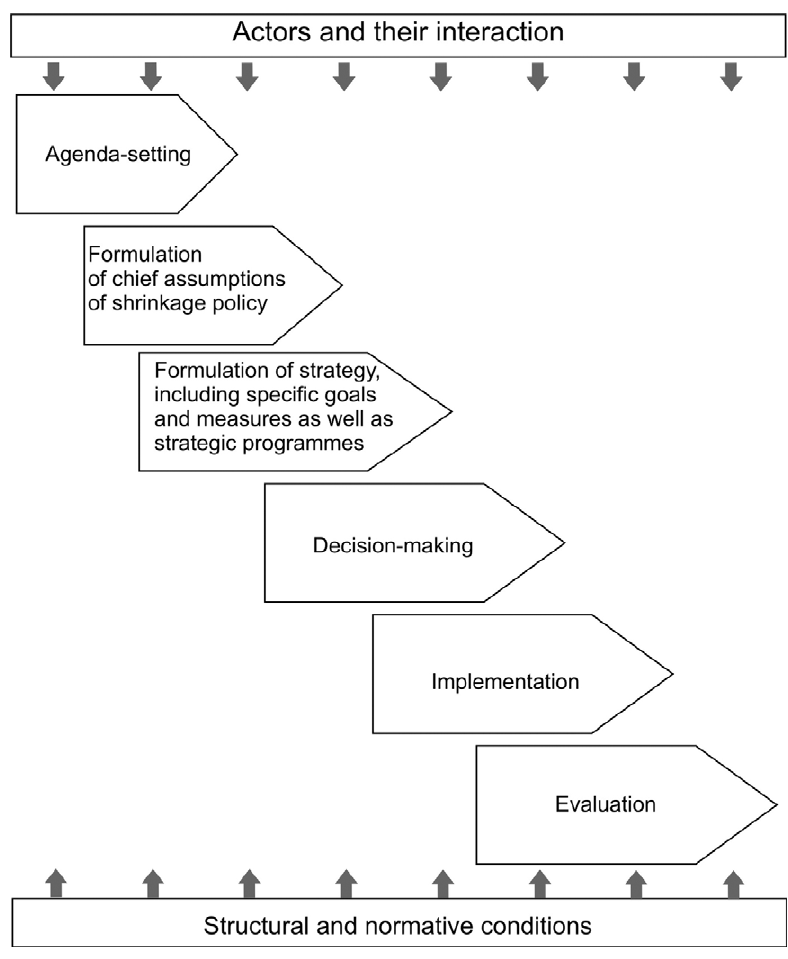
Fig. 4. Stages of urban policy implementation in shrinking